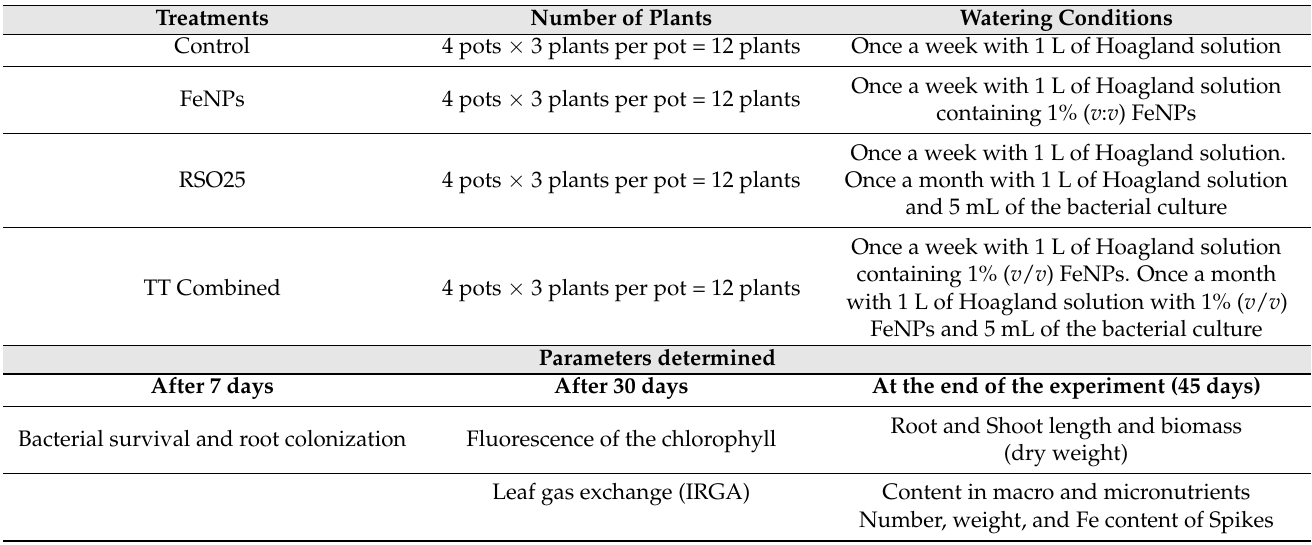
Table 1. Scheme of the experimental design and the parameters